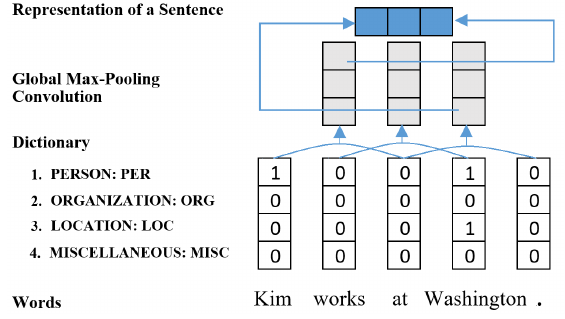
Figure 3. CNN-based sentence encoding using dictionary